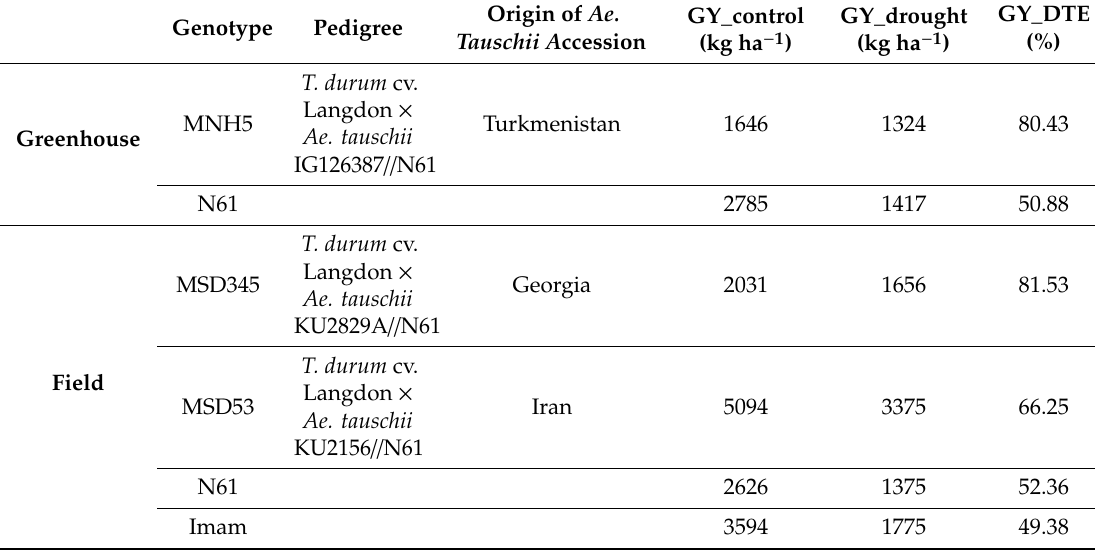
Table 1. Pedigrees of the three multiple synthetic derivative lines (MSDLs) and their yield performance under control and drought stress conditions compared with their backcross parent, “Norin 61” (N61), and a Sudanese cultivar,